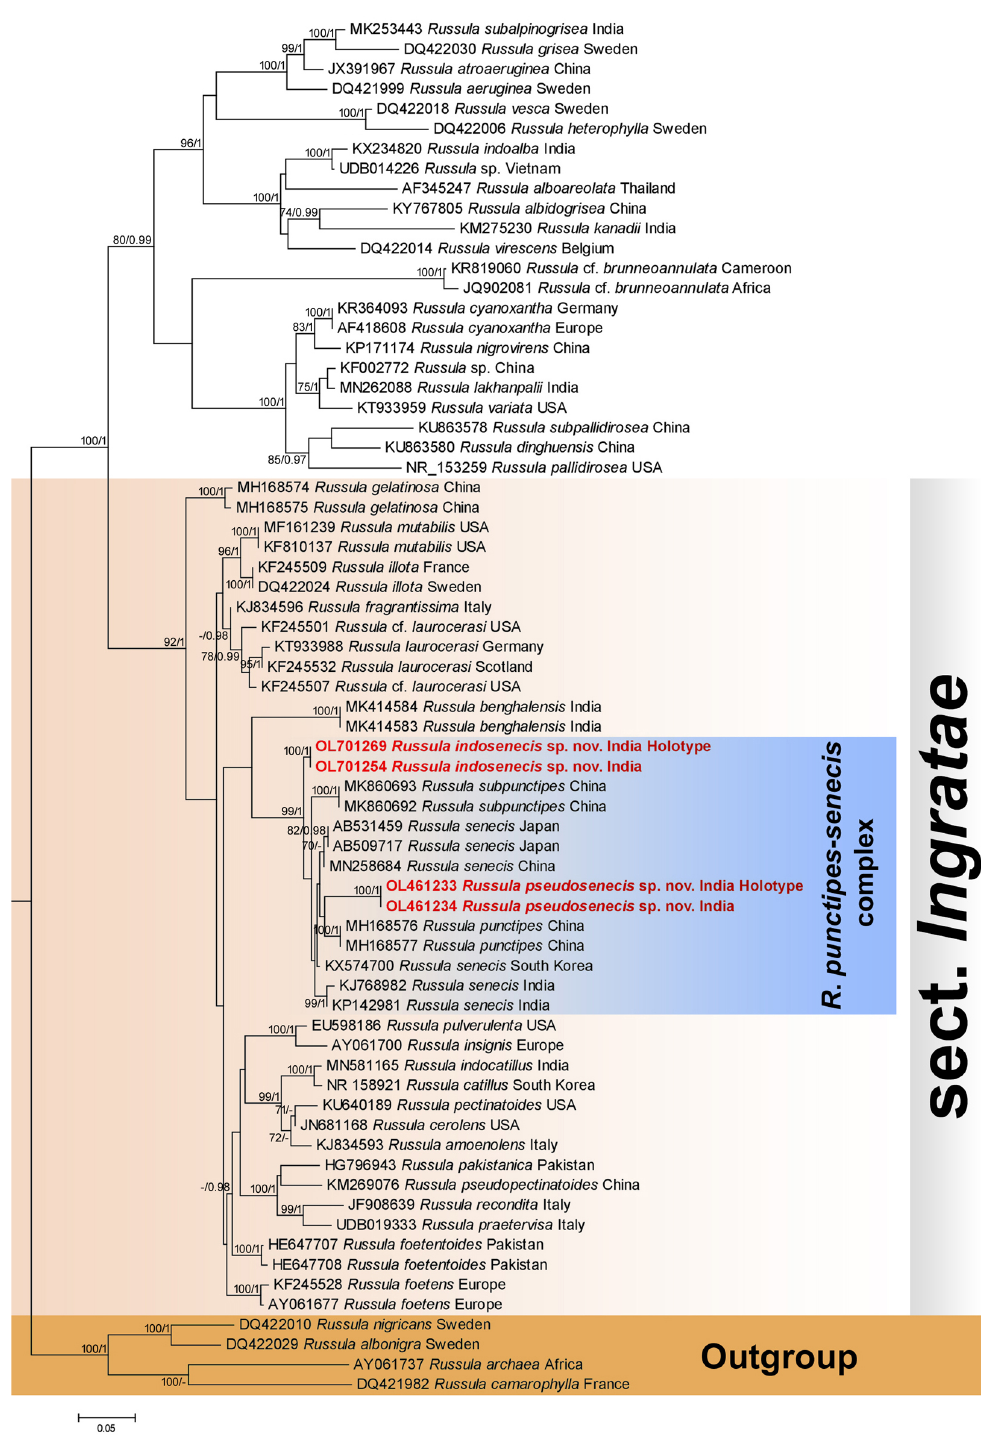
Fig. 1. Phylogram generated by maximum likelihood analysis based on sequence data of nrITS for Russula indosenecis A.Ghosh, D.Chakr., K.Das & Buyck sp. nov. and R. pseudosenecis A.Ghosh, D.Chakr., K.Das & Buyck sp. nov. and their allied species. Maximum likelihood bootstrap support values (MLbs) ≥ 70% are shown on the left of ʻ/ʼ and Bayesian posterior probabilities (BPP) ≥ 0.95 are shown on the right above or below the branches at nodes. R . indosenecis sp. nov. and R . pseudosenecis sp. nov. are placed in bold red font to highlight their phylogenetic positions in the